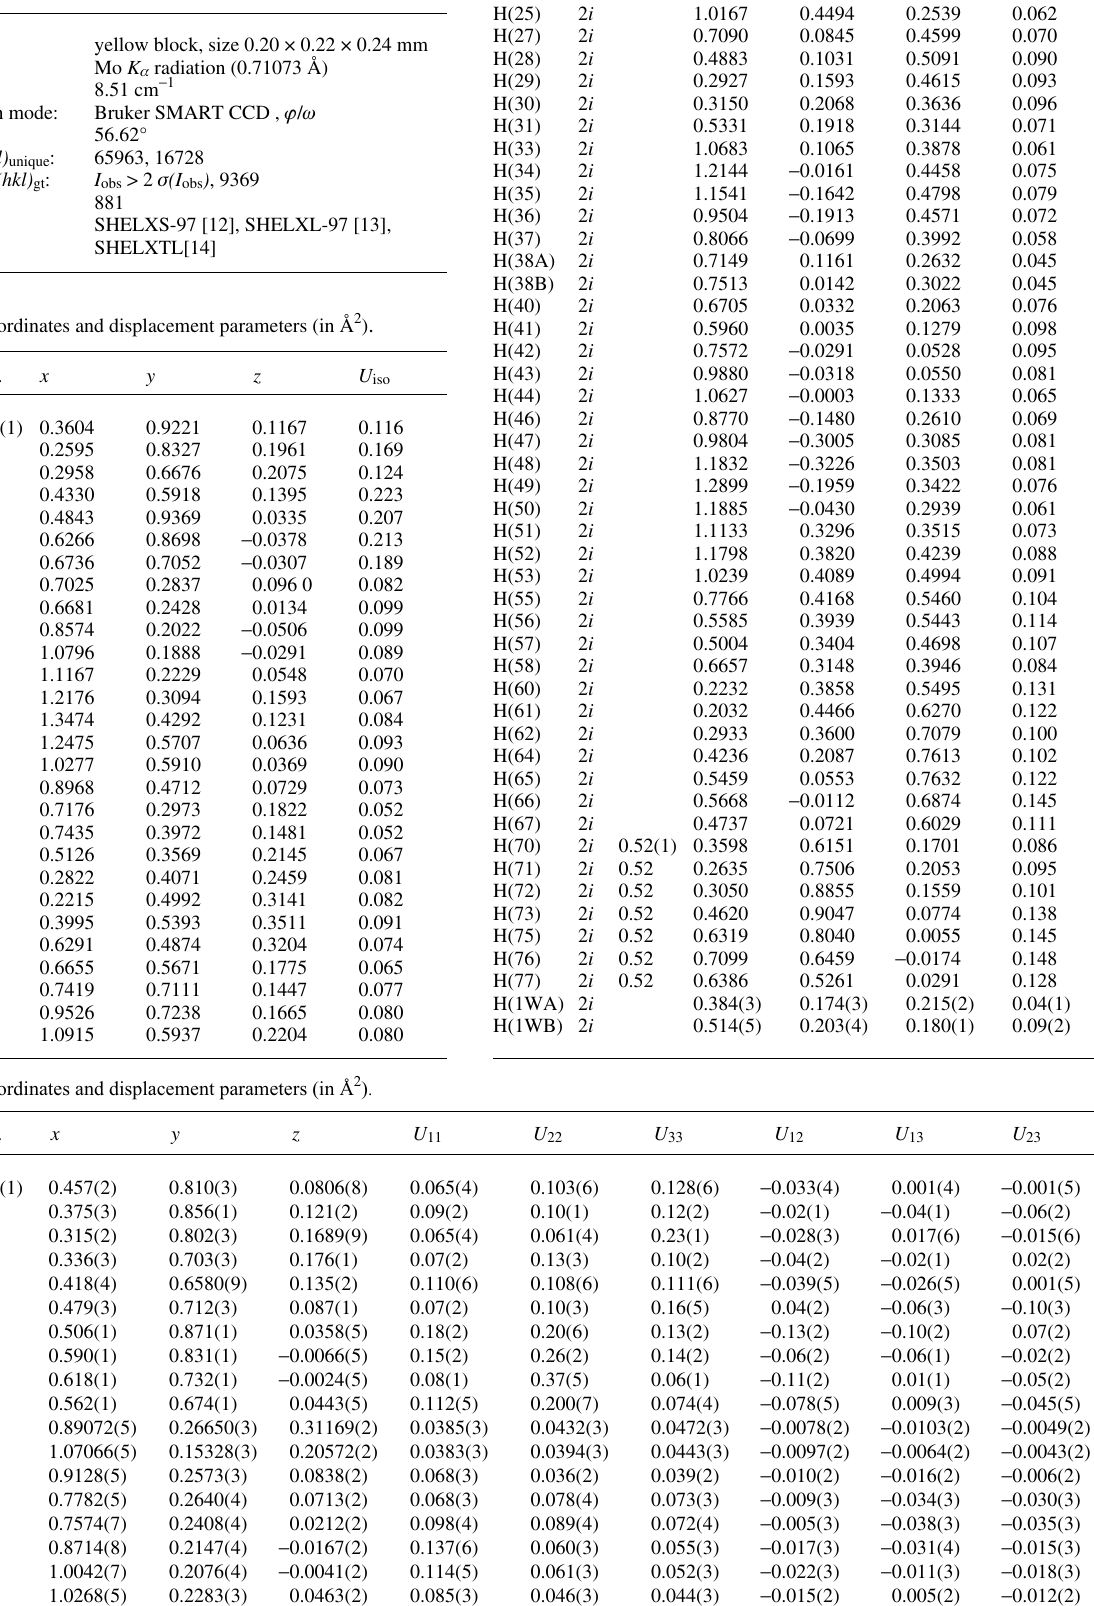
Table 1. Data collection and